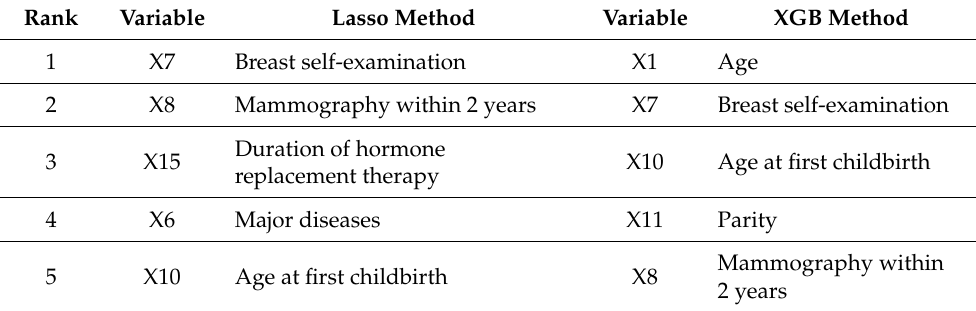
Table 3. Variable importance rankings of Lasso and XGB